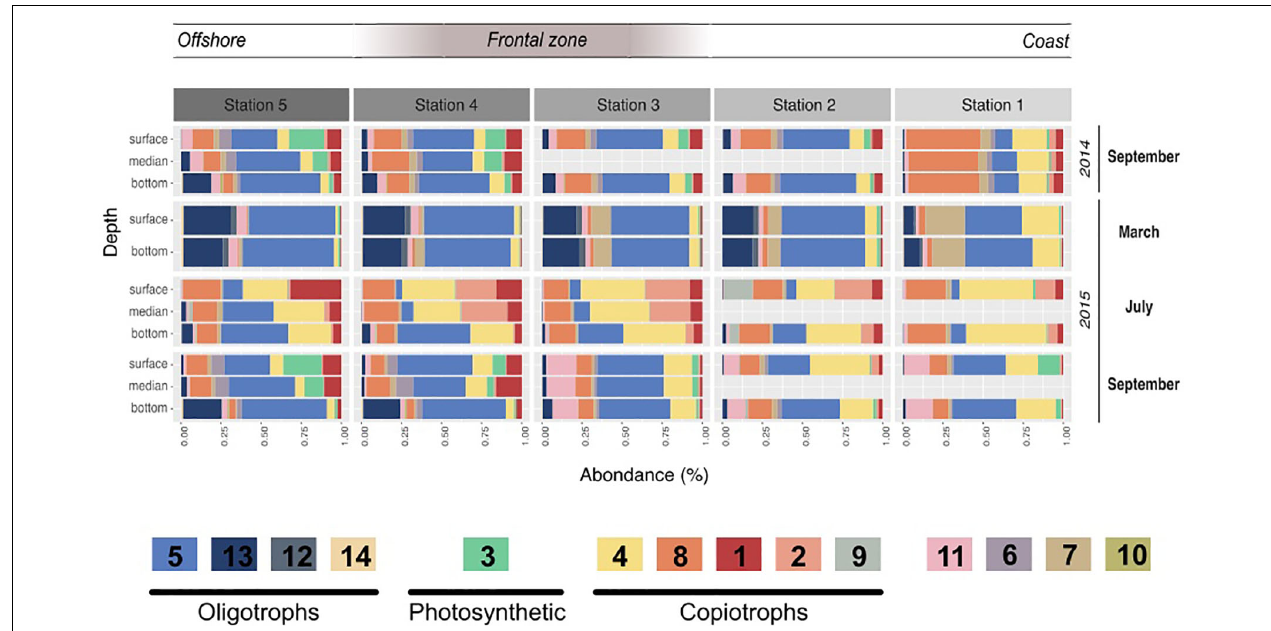
FIGURE 3 | Module dynamics across the different campaigns, stations, and depths. Relative abundance of the different modules in each campaign, station and depth. The value shown resulted of the mean of the triplicates done for each sampling. The legend includes the different hypotheses of the modules’ trophic strategies based on their correlations to the environmental parameters, their taxonomy and their dynamic. Oligotrophic modules are likely to present heterotrophic bacteria adapted to low organic matter levels, while copiotrophic bacteria are likely more competitive under higher organic matter levels. Finally the photosynthetic module is almost only composed of